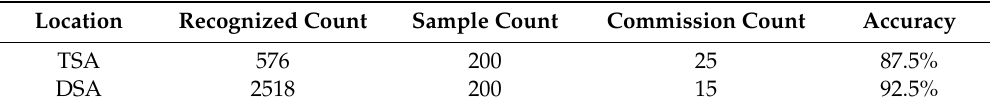
Table 6. Accuracy of CODA shrub identification results in the TSA and DSA.